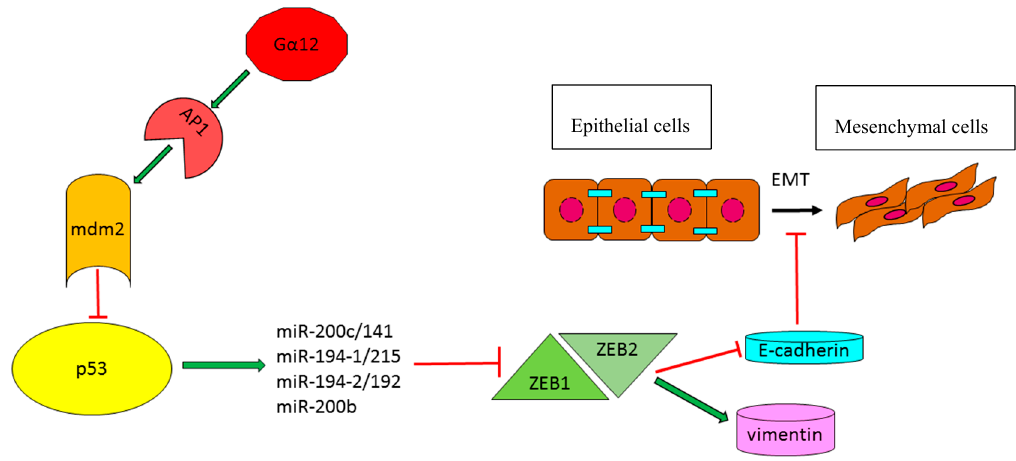
Figure 1. P53-effector miRNAs involved in epithelial–mesenchymal (EMT) transition in HCC. Green arrows: Induction of gene expression or protein activation. Red lines: Inhibition of gene expression or block protein activity. Black arrows: Epithelial to mesenchymal transition process.